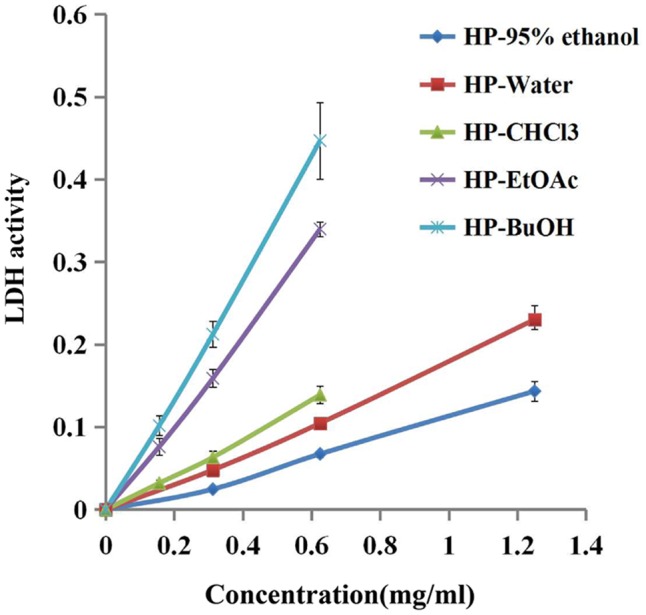
Bacterial cell damage within the biofilm based on LDH activity in different test samples. The extracts of B. crassifolia leaves were serially diluted twofold in BHI broth containing 1% sucrose from 1/8 MIC to MIC respectively. The graph represents the actual concentrations of the MIC dilutions.